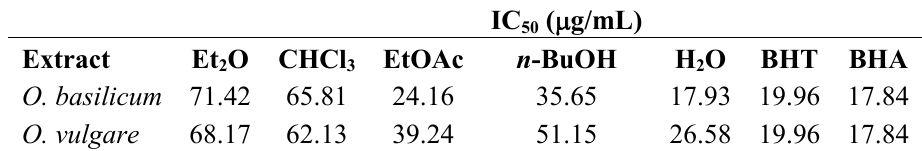
Table 5. IC values ( μ g/mL) of the neutralization of H 50 and O. vulgare